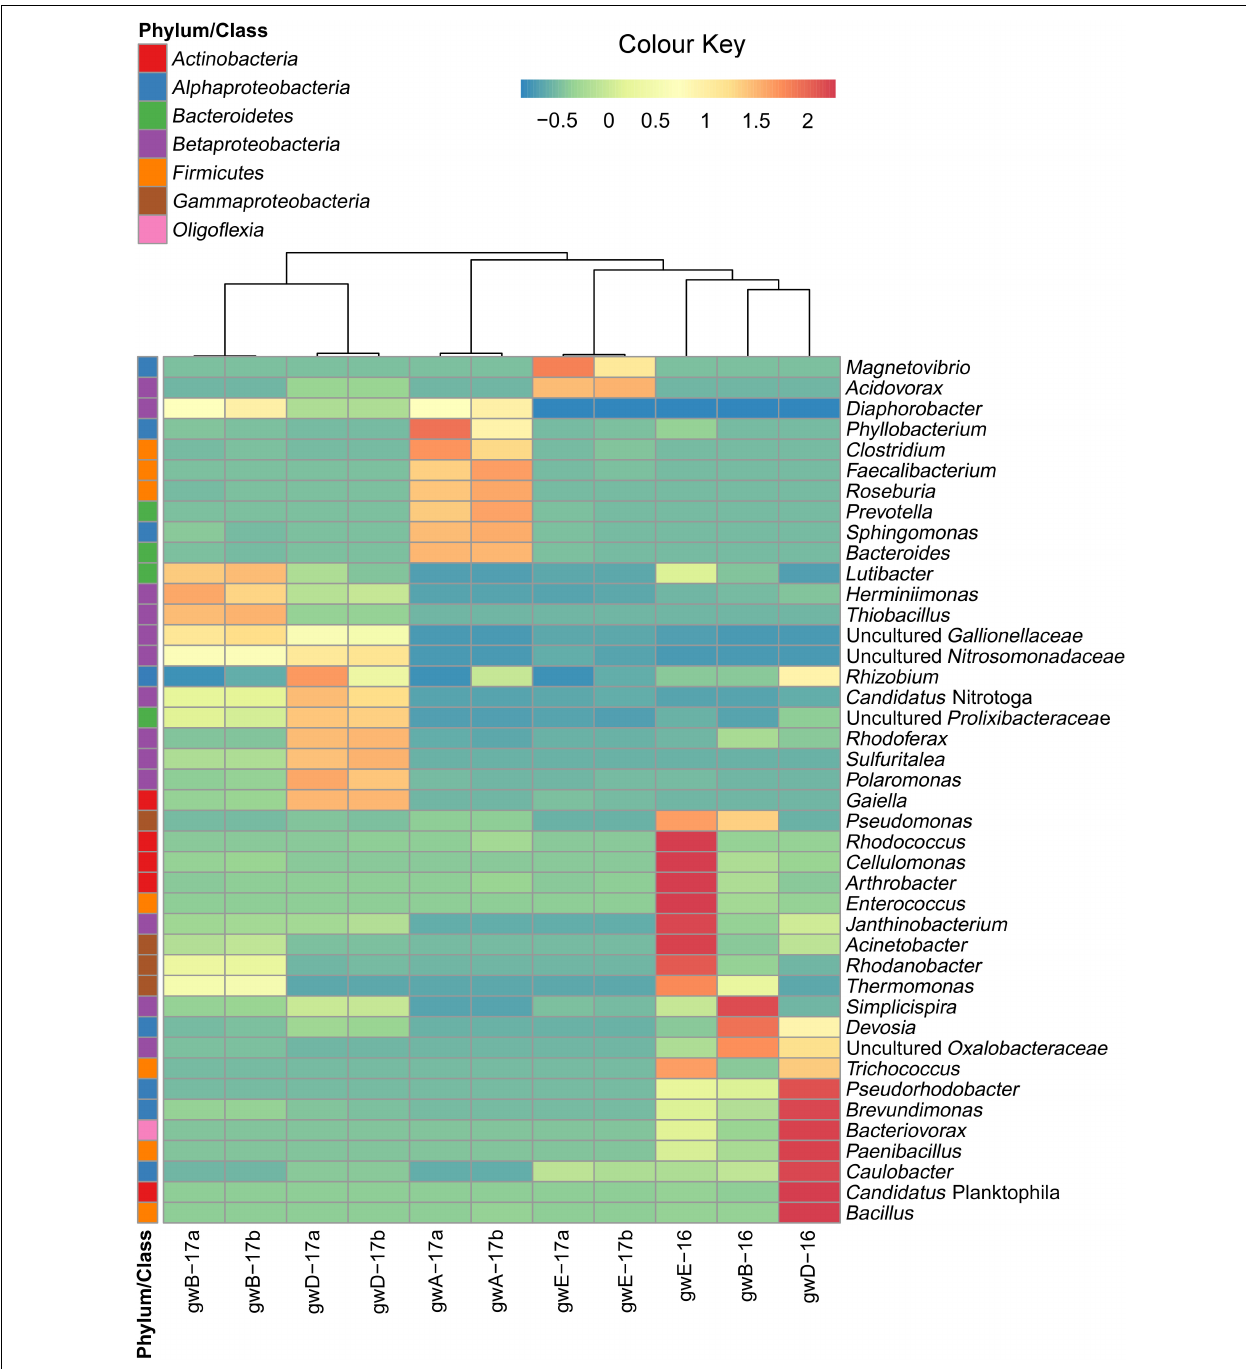
FIGURE 3 | Heatmap analysis of the dominant genera distribution in seven groundwater samples. The double hierarchical dendrogram shows microbial distribution in these samples. The relative values for microbial genera are marked by colors from green to red designating the least abundant to most abundant. Abundance is expressed as the number of targeted sequences to the total number of sequences from each groundwater sample.